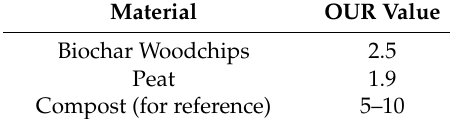
Table 5. Oxygen uptake rate (OUR) of biochar and peat in mmol · h − 1 · kg − 1 dry organic matter.